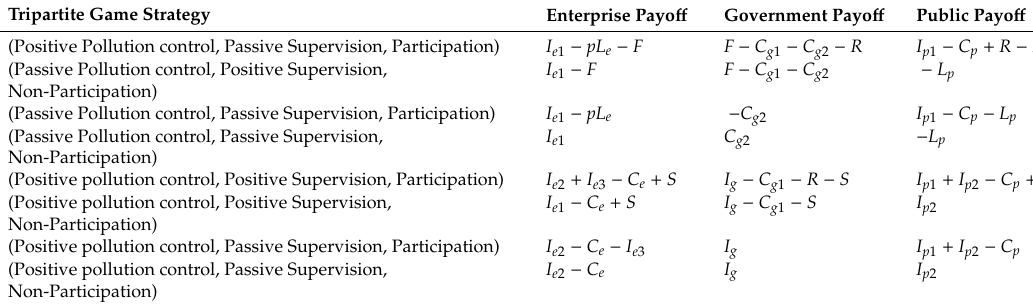
Table 2. Pay-o ff matrix of government, enterprise, and